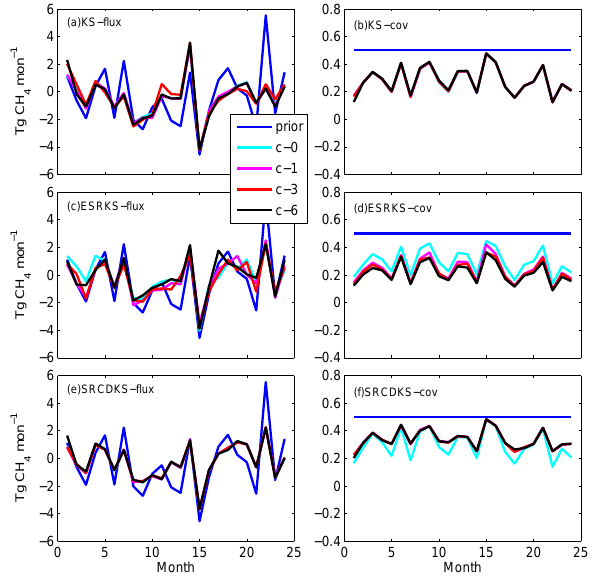
Fig. 5. Two-year comparison of the posterior fluxes and posterior uncertainties between inversions using the different Kalman update smoothers. The true fluxes have been subtracted from the time se- ries for a better illustration. The ensemble size for ESRKS is 500, and that for SRCDKS is 101. Interval constraints are applied for all Kalman update smoothers using the different algorithms described in the text.